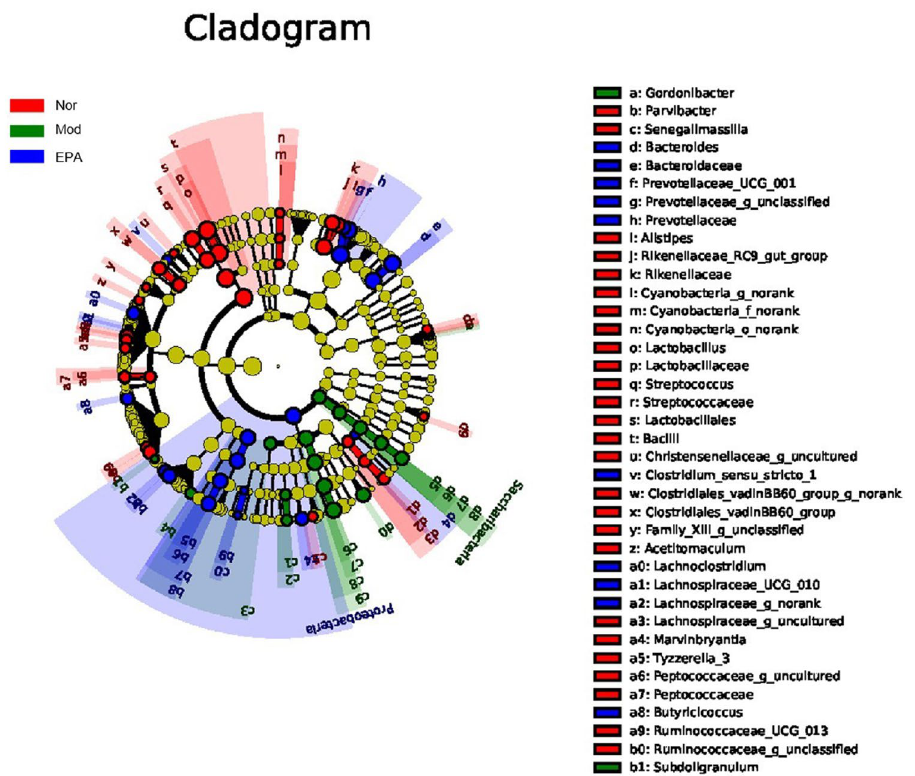
Figure 14. The LDA score obtained from LEfSe analysis of gut microbiota in different